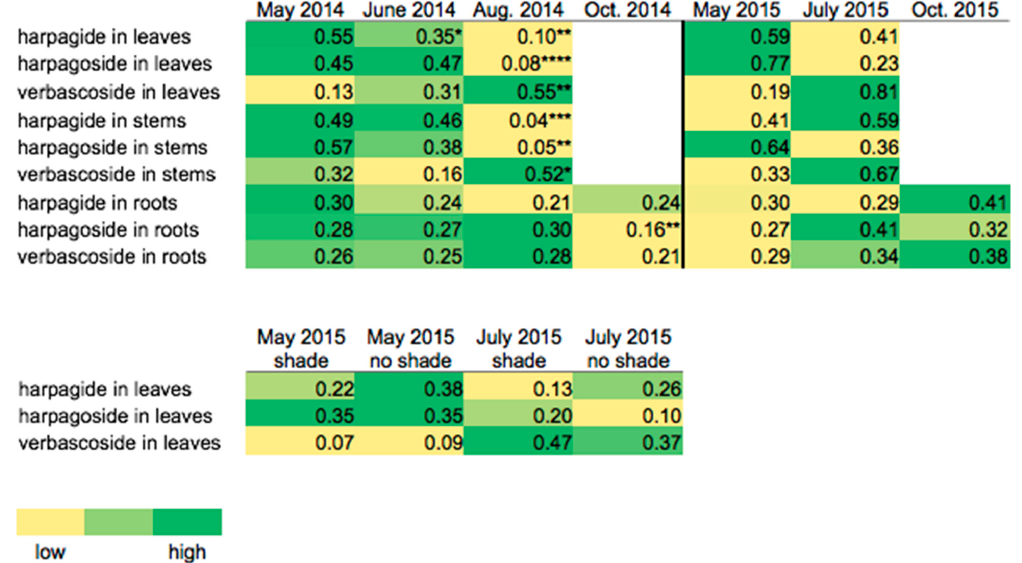
Figure 5. Heatmaps comparing relative abundances (low [0.00] to high [1.00]) of harpagide, harpagoside, and verbascoside in S. marilandica tissues (leaves, stems, and roots) over the growing season and under shade and no shade treatments. For the October 2014 and October 2015 harvests, the plants had mostly senesced for the season; therefore, only the roots were collected. The vertical black line between the 2014 and 2015 seasons indicates that the seasons are not continuous. Statistical significance ( p ≤ 0.05) was determined by independent/unpaired two-sample t -test or Wilcoxon test. *, significant at p ≤ 0.05; **, significant at p ≤ 0.01; ***, significant at p ≤ 0.001; and ****, significant at p ≤ 0.0001. Figure S2 shows a bar chart version of this